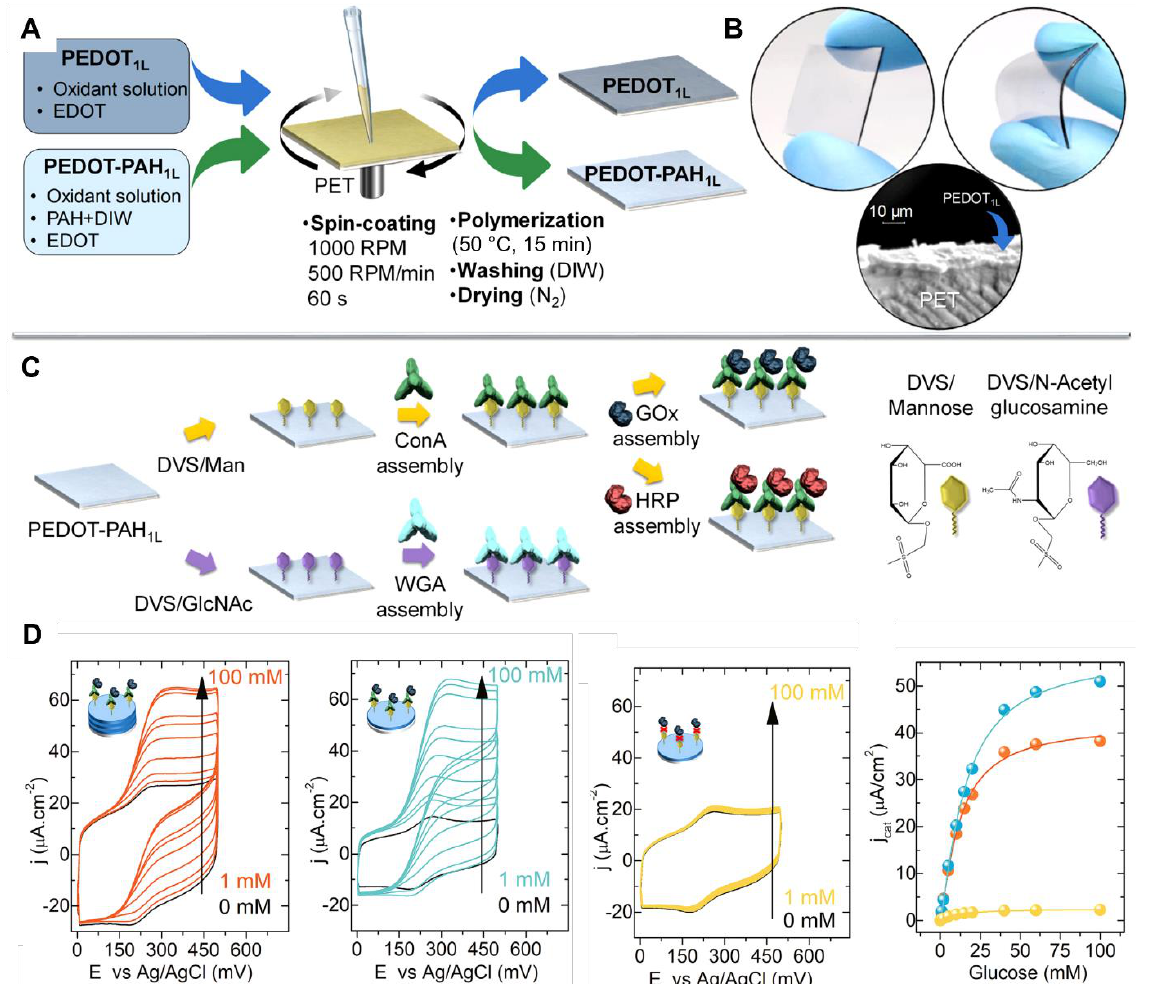
Figure 14. Scheme for the fabrication of PEDOT and PEDOT-PAH1L films by spin-coating on PET foils ( A ). Images of a flexible PET foil substrate modified with film of PEDOT-PAH ( B ). Sequential functionalization of the PEDOT-PAH composite ( C ). Cyclic voltammograms and current densities of the glucose oxidation for Con A/GOx-functionalized films prepared with different PEDOT-based layers (red, 1 layer of PEDOT-PAH, light blue, 2 PEDOT layers+1 layer of PEDOT-PAH). The yellow curves correspond to the PEDOT-PAH electrode without ConA ( D ). Adapted with permission from reference [90]. Copyright 2020 Elsevier.